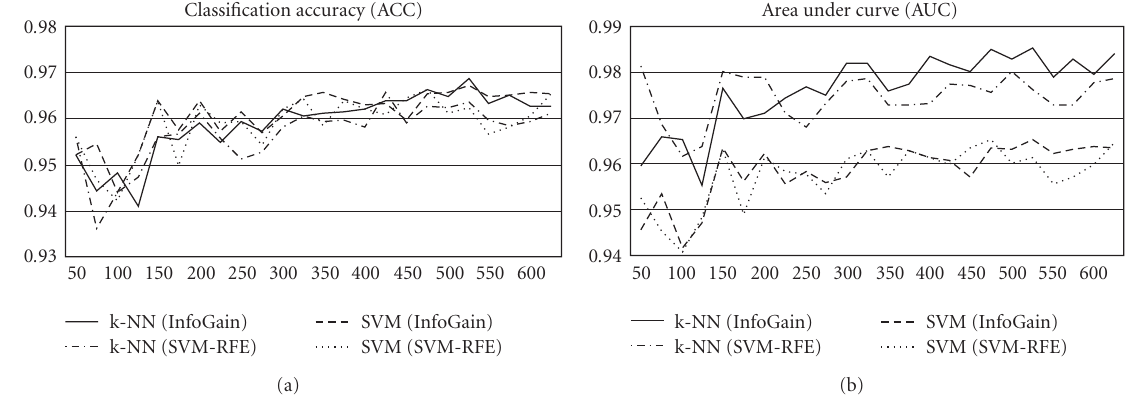
Figure 3: Classification accuracy and AUC using four di ff erent classification models (breast versus colon cancer dataset).